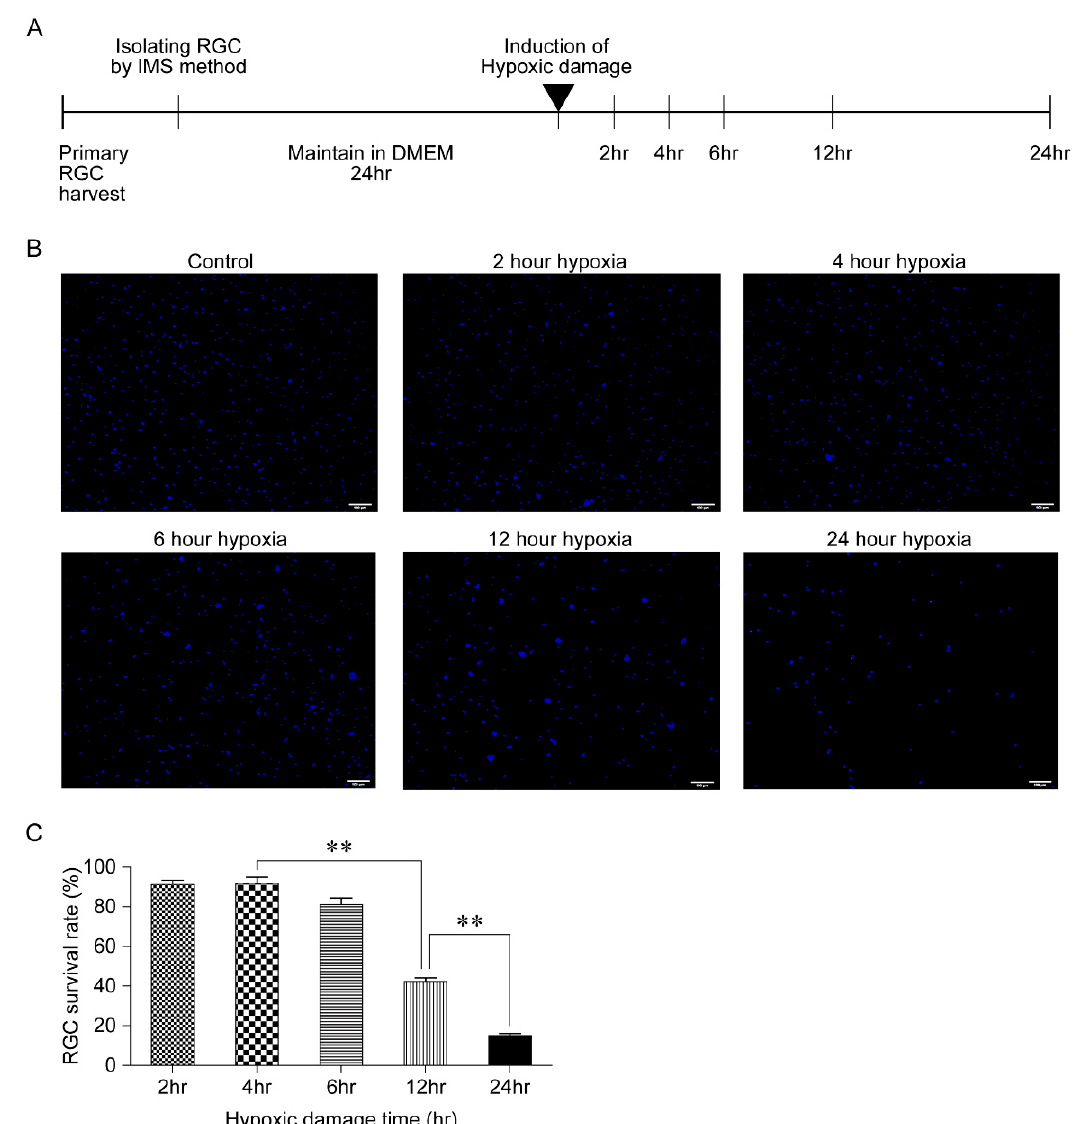
Figure 1. Consequence of varying durations of exposure to hypoxic conditions in primary retinal ganglion cells (RGCs). ( A ) After harvesting primary RGCs from the postnasal rat retinas, the cells were maintained for 24 h in a defined medium; then, hypoxic damage was inflicted on the cells in a CO 2 chamber. After exposure to hypoxic conditions for 2, 4, 6, 12, and 24 h, the cells in each sample were counted. ( B ) Representative images of RGCs after exposure to hypoxic conditions for 2, 4, 6, 12, and 24 h. Scale bar, 100 µ m. ( C ) Number of RGCs after exposure to hypoxic conditions for 2, 4, 6, 12, and 24 h. Data in the columns indicate the mean survival rate ± SD. Differences in RGC survival rates are indicated (** p < 0.01).